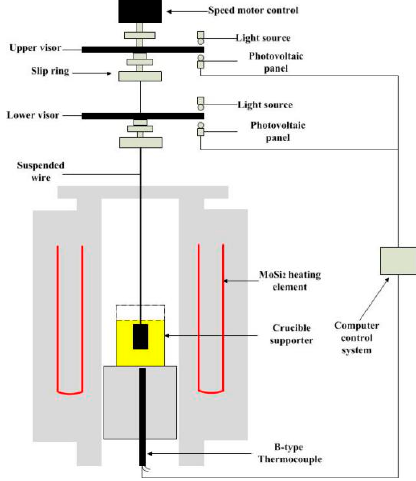
Figure 2. Schematic of viscosity measurement apparatus.